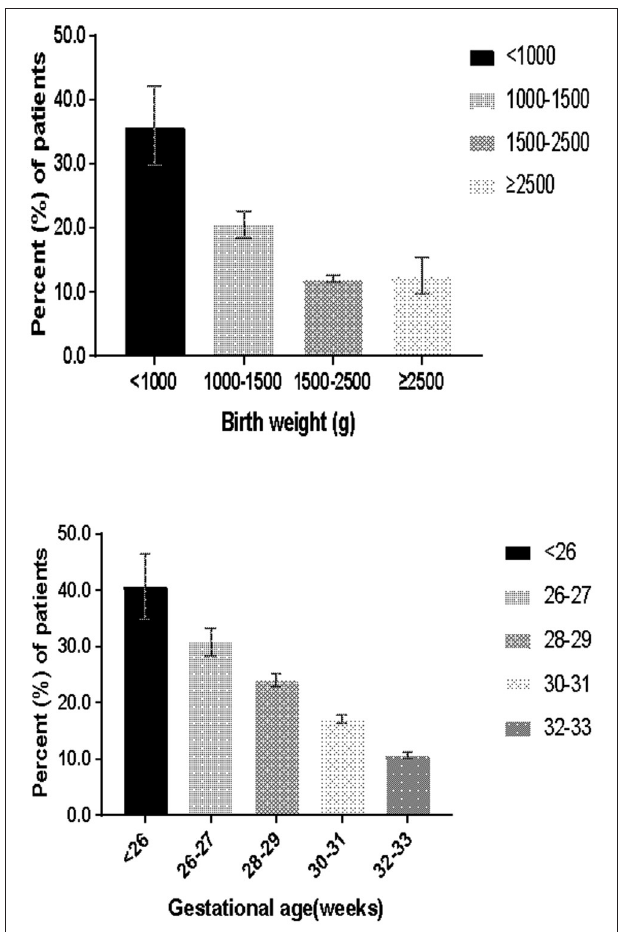
FIGURE 1 | Percentage of patients receiving cardiovascular pharmacological